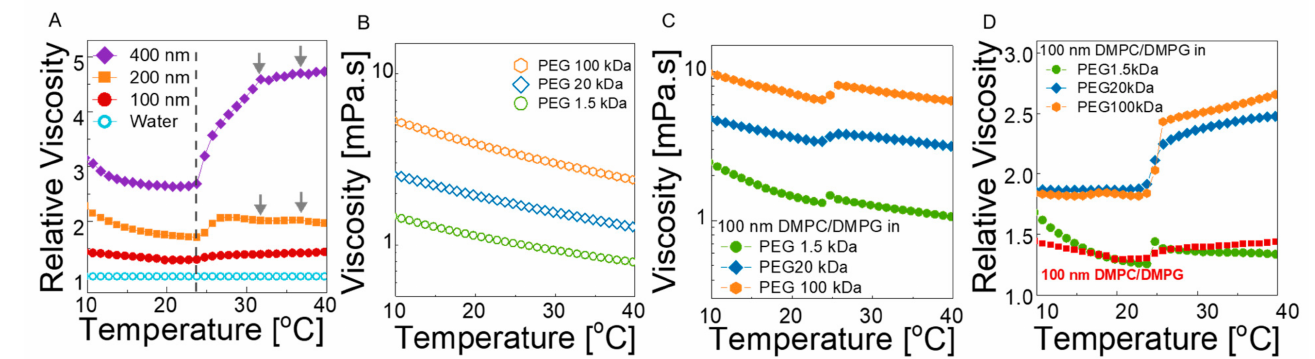
Figure 4. ( A ) Relative viscosity of 400 nm, 200 nm, and 100 nm liposomes with respect to water. Vertical dashed line shows the phase transition temperature. Viscosity of ( B ) neat 1.7 wt% PEG solutions with varying M w s (1.5 kDa, 20 kDa, and 100 kDa) and ( C ) composite solutions containing 1.7 wt% lipids and 1.7 wt% polymer in water. ( D ) Relative viscosity of composite solutions containing 1.7 wt% lipids and 1.7 wt% polymer in water with respect to neat PEG solutions. All